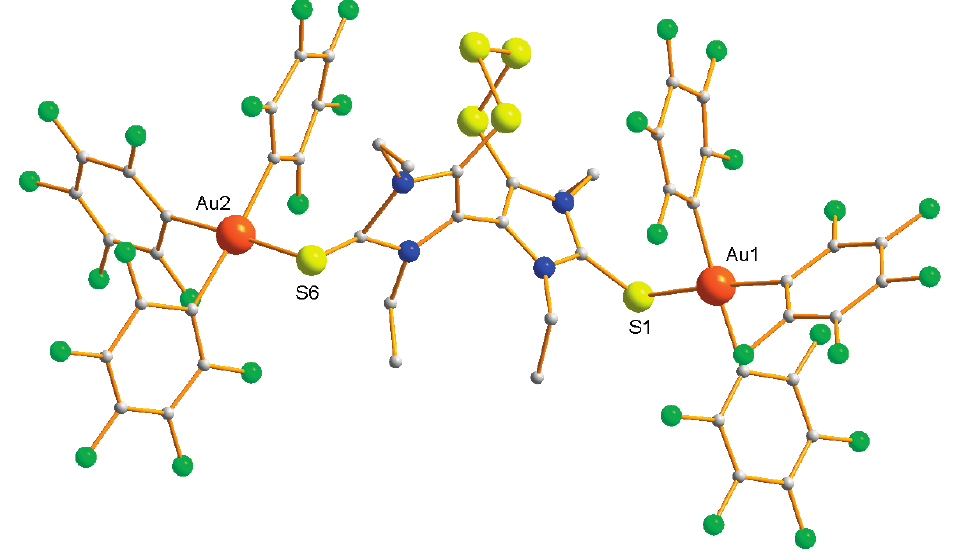
Figure 3. Molecular structure of the compound 3 (hydrogen atoms omitted for